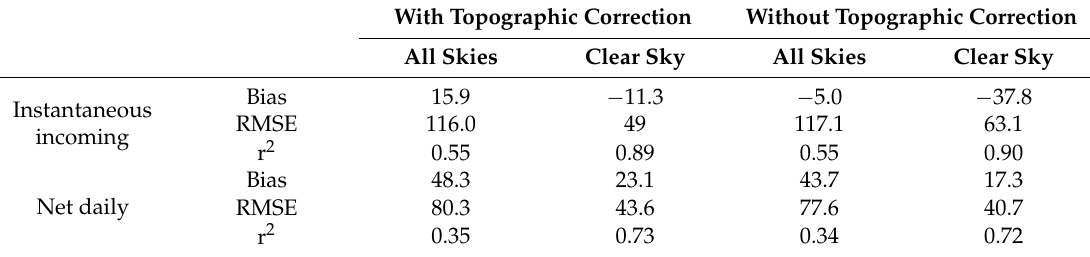
Table 4. Comparison of solar radiative fluxes estimated with and without topographic correction at Qomolangma station for the year 2009. The bias (W ¨ m ´ 2 ), the RMSE (W ¨ m ´ 2 ) and the r-square are provided for all skies and clear sky.